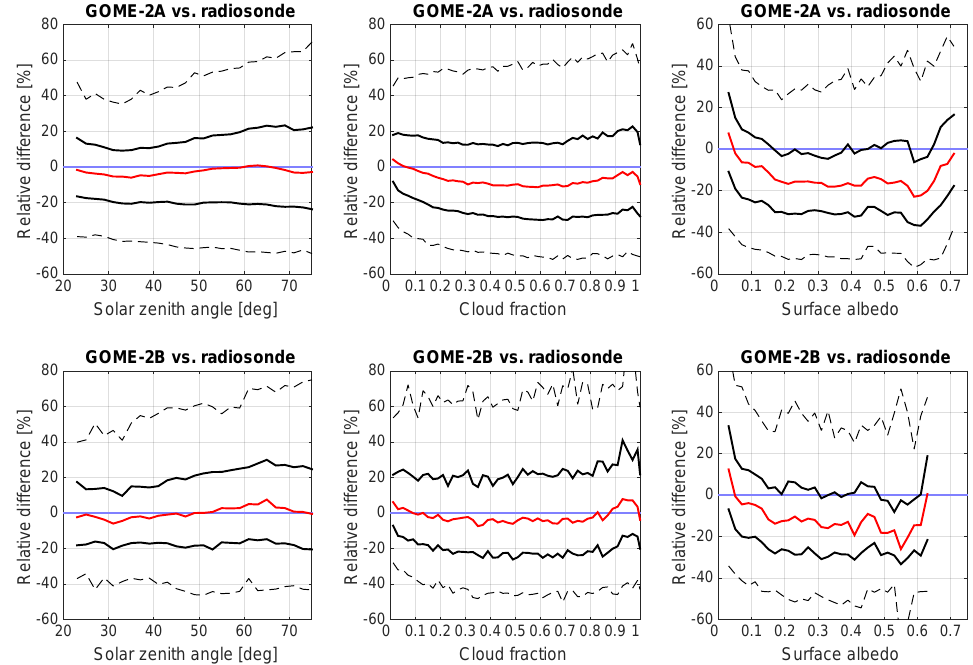
Figure 6. Median relative differences (red solid line), 25 and 75% percentiles (black solid lines) and 5 and 95% percentiles (dashed lines) for GOME-2A (top) and GOME-2B (bottom) against radiosonde as a function of solar zenith angle (left), geometric cloud fraction (centre) and surface albedo